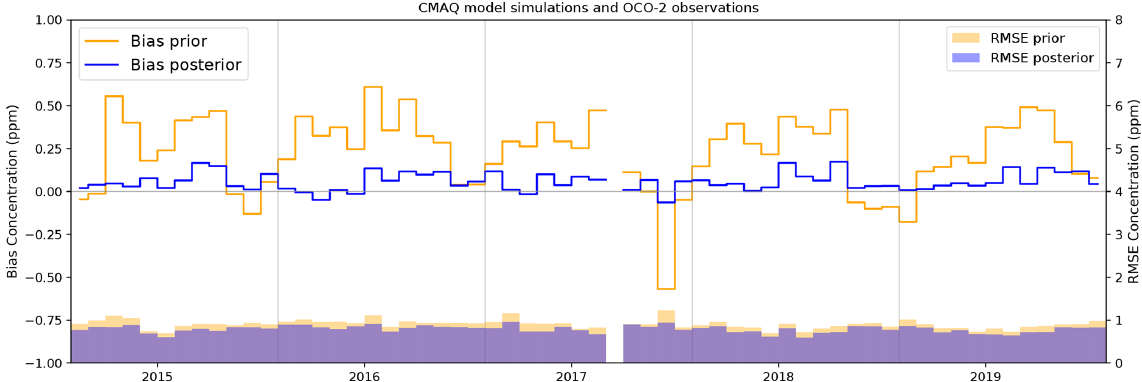
Figure 3. Bias and root-mean-square error (RMSE) between OCO-2 and the prior and posterior concentrations simulated by the CMAQ model. The respective orange and blue lines represent prior and posterior concentration biases, and the respective orange and purple shaded areas represent the prior and posterior RMSE.